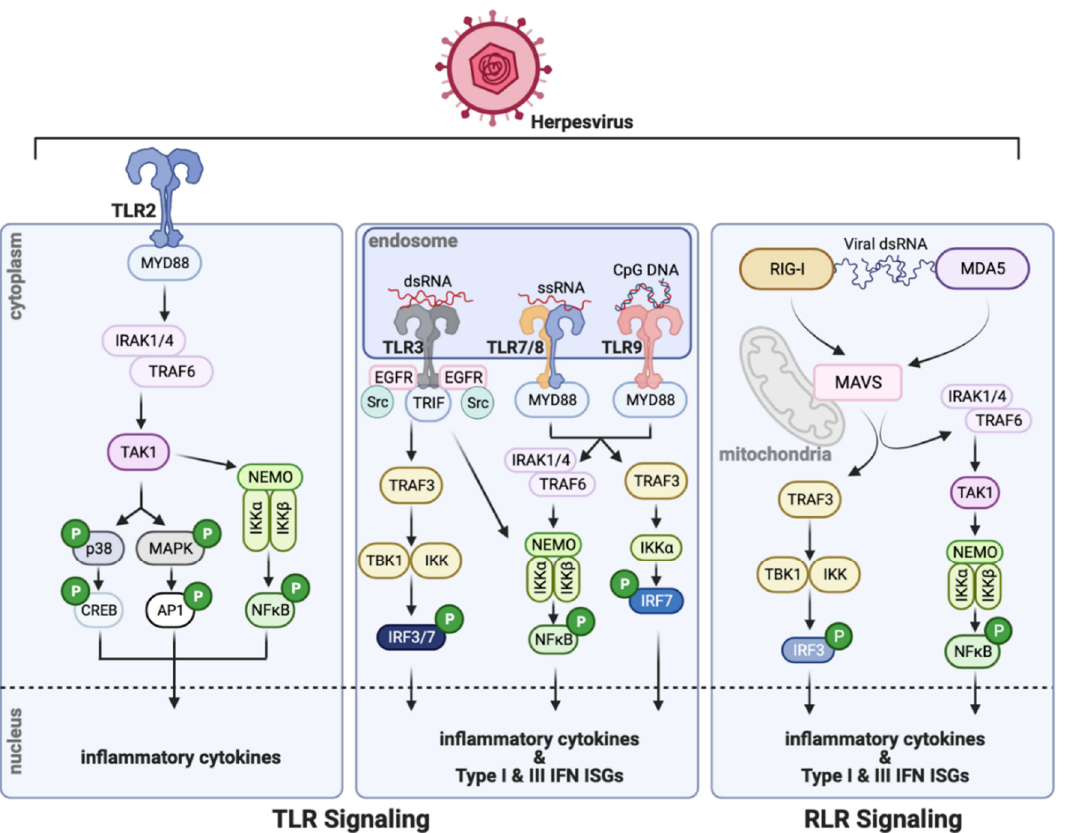
Figure 1. Herpesvirus infection triggers PRR signaling. TLR signaling is induced from the cell membrane (left) or endosomal membrane (middle). TLR2-mediated signaling (left) via MyD88 interaction via TLR2 ′ s cytoplasmic domain, activates transcription factors that in turn initiate inflammatory cytokine and ISG transcription. TLR3, TLR7/8, and TLR9 signaling from endosomes (middle) is activated by dsRNA, ssRNA, or CpG DNA, respectively. Downstream activation of NF ĸ B, IRF7, or IRF3 leads to the upregulation of inflammatory cytokine and ISG production. The cytoplasmic RLR family of PRRs (right), such as RIG-I, use MAVS as an adaptor for innate signaling, resulting in the activation of inflammatory cytokines and ISGs. The data summarized in this figure is reviewed in ref. [4]. Created with BioRender.com (accessed on 13 August